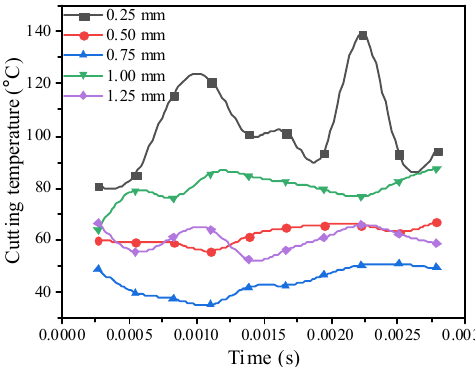
Figure 8. Comparison curve of the cutting temperature under different milling depths.